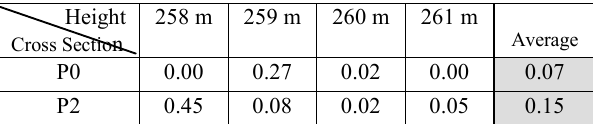
Figure 10. Example of a cross section (P0), Divisa do Parque area, Rosana reservoir: (a) June, 2013 and; (b) January, 2014.